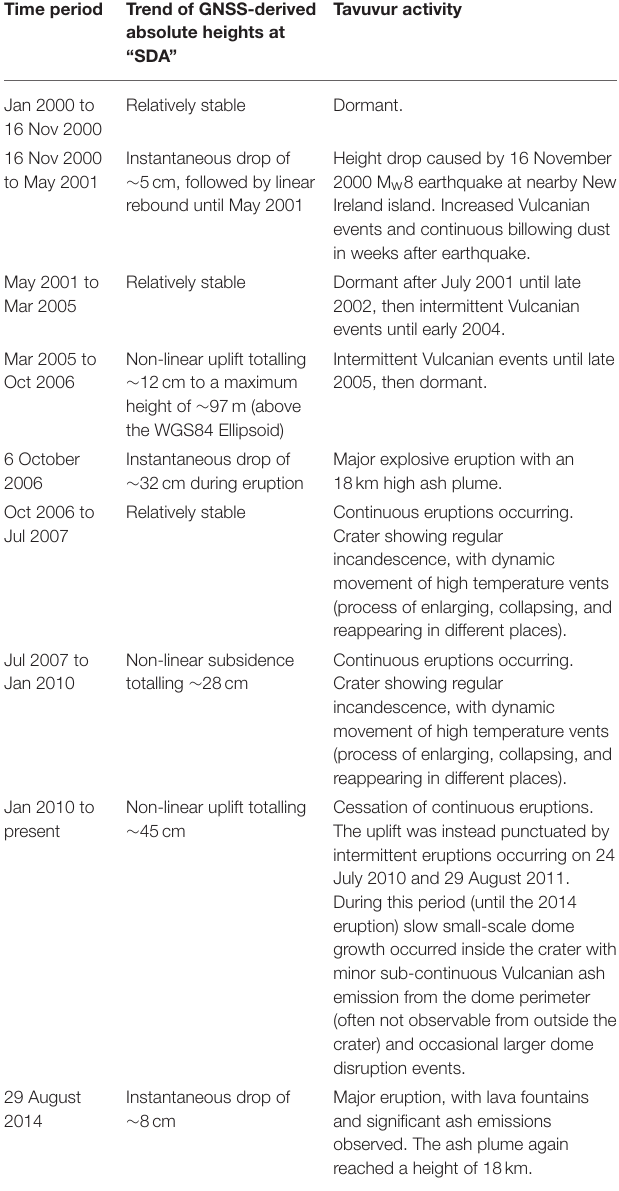
TABLE 3 | Record of recent Tavuvur eruptive activity since January 2000 and trends in absolute height change measured by GNSS at station “SDA” located at Matupit (see Figure 3